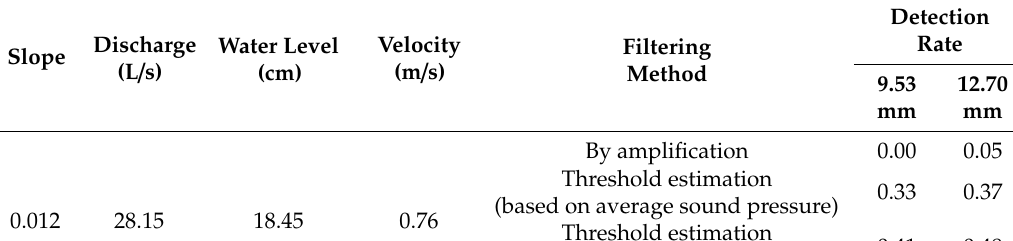
Table 8. Particle detection rate by filtering method.